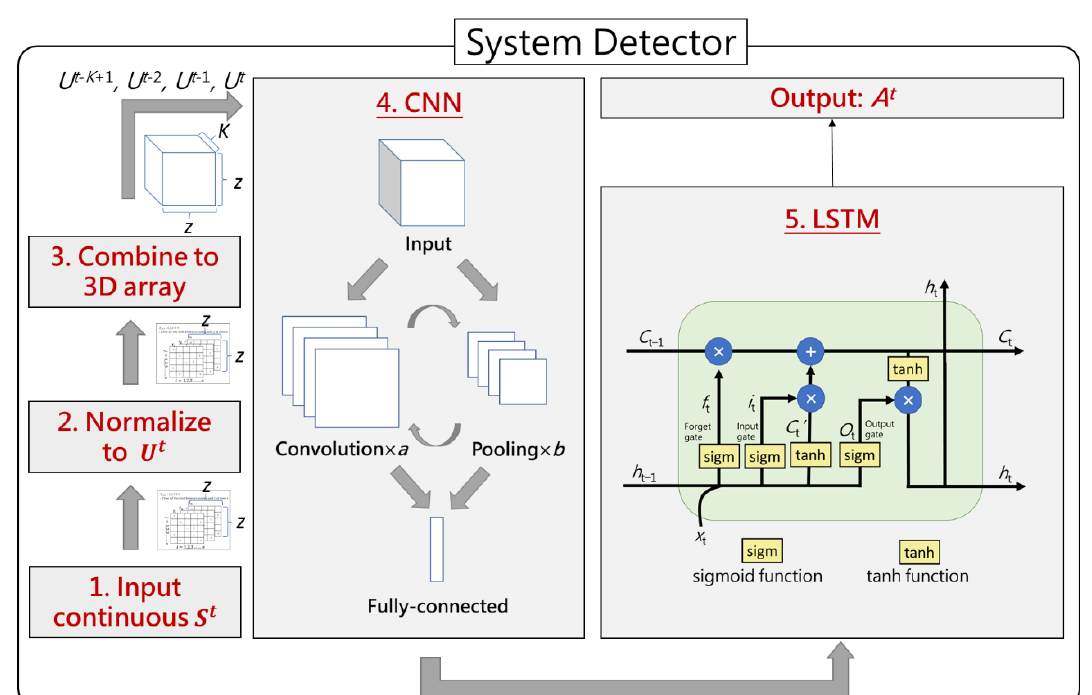
Figure 6. Architecture of System Detector module.